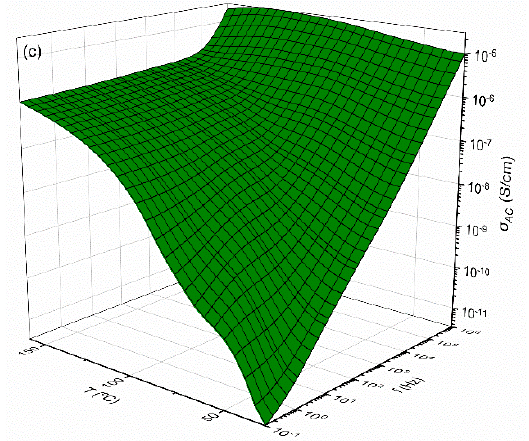
Figure 3. Dielectric spectra of 10 phr SrFe 12 O 19 /10 phr BaTiO 3 /epoxy nanocomposite as a function of temperature and frequency for the: ( a ) real part of dielectric permittivity, ( ε ′ ), ( b ) loss tangent (tan δ ) and ( c ) AC conductivity ( σ AC ).